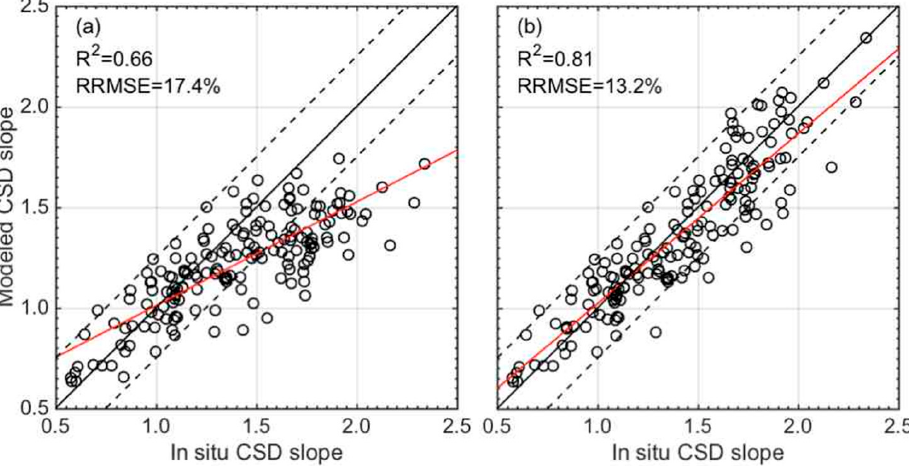
Figure 5. Comparison between in situ and modeled CSD slope using the CSD slope: ( a ) before; and ( b ) after involving a condition branch. Solid line represents regression line, black and gray dashed lines indicate the 1:1 agreement and ±0.25 ranges, respectively.